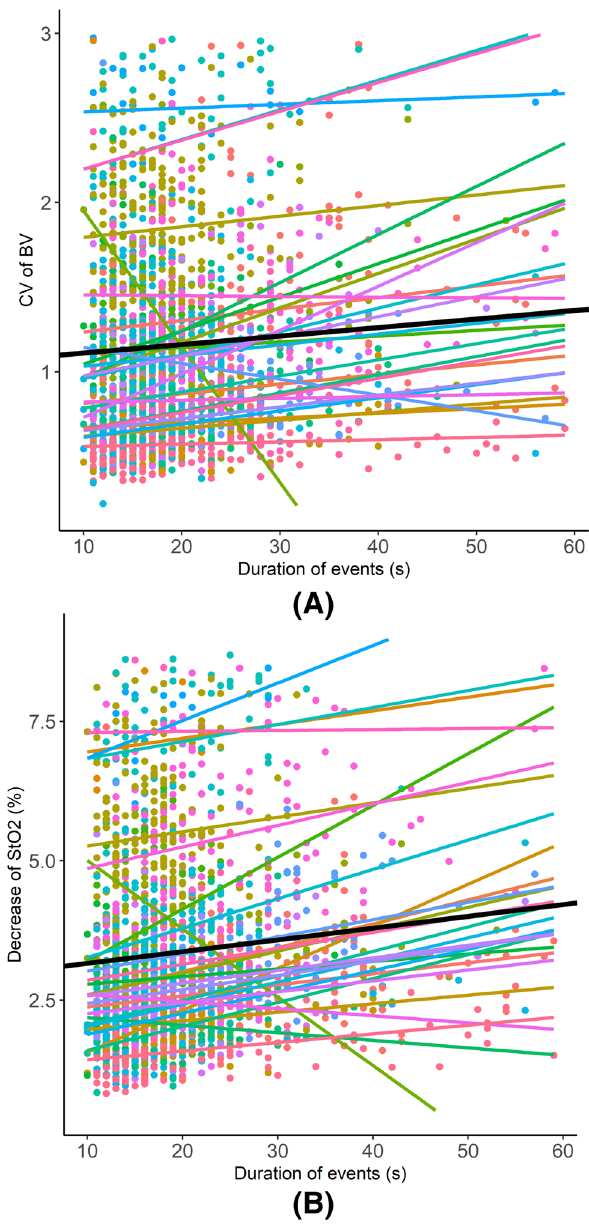
Figure 4. The changes in the coefficient of variation (CV) of cerebral blood volume (BV) and the decrease of cerebral tissue oxygen saturation (StO2) versus the duration of events in each patient. The data points of different colors indicate data from different patients, and the lines of different colors are the linear fitting of the data points. The black line is the mean of all patients. We only show the events of durations shorter than 60